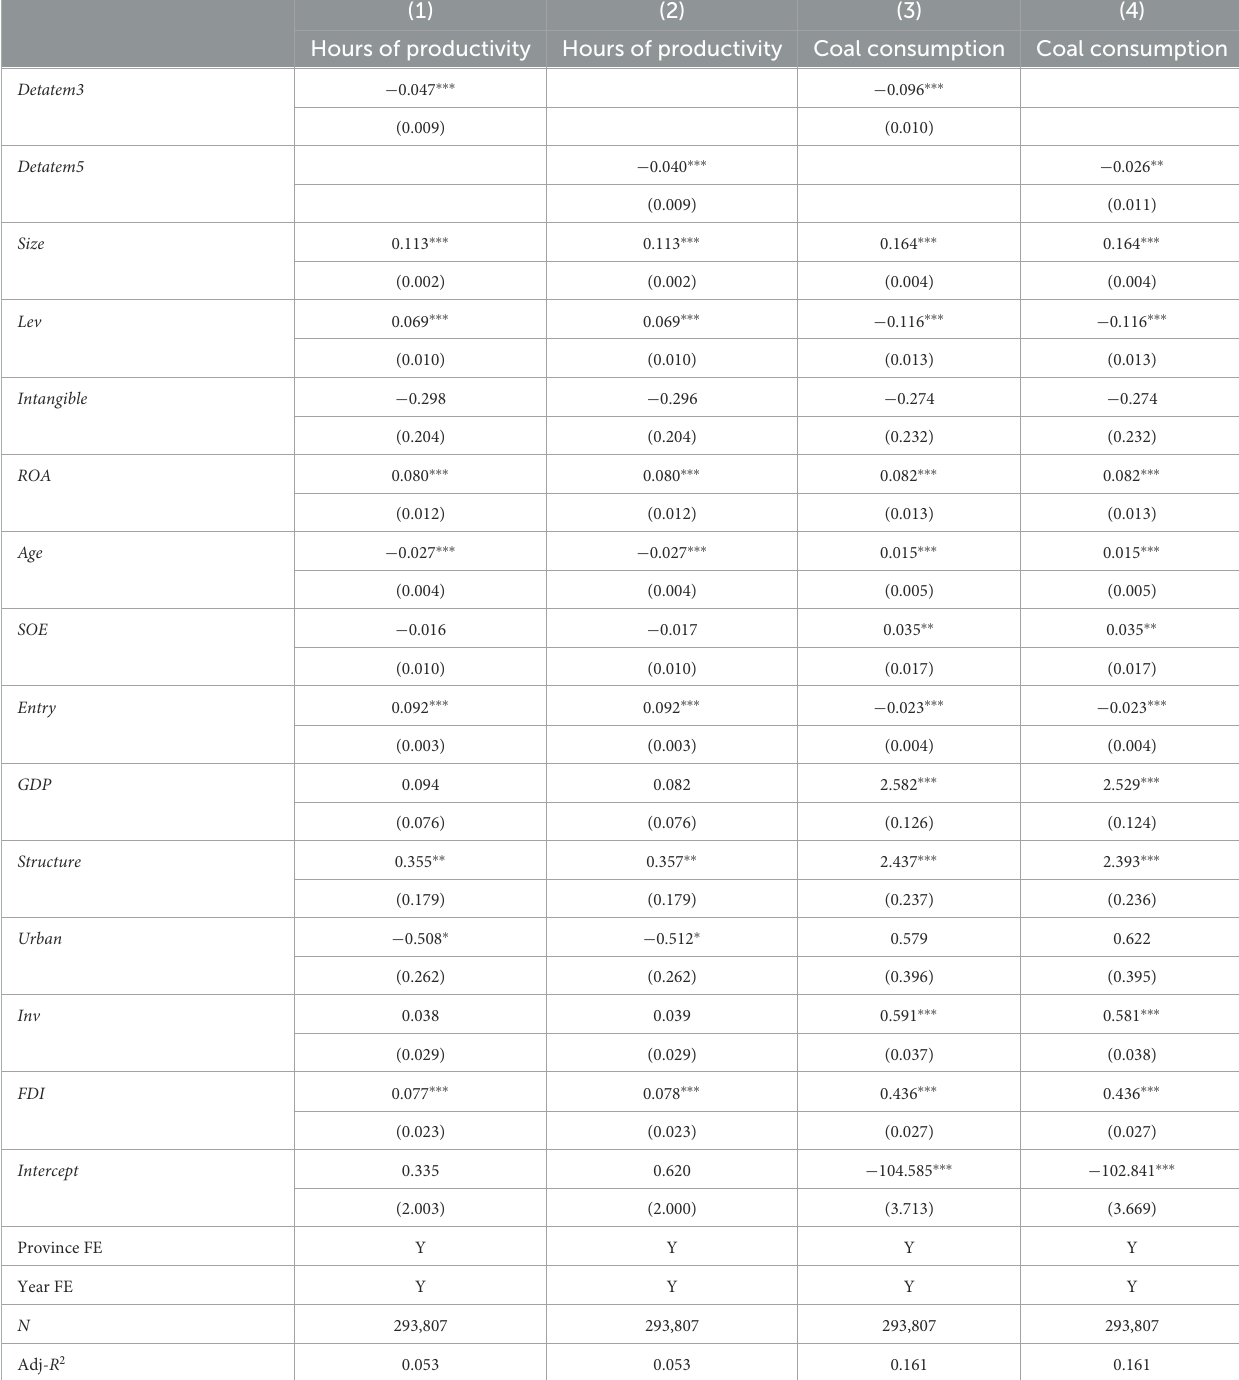
TABLE 12 Climate change and firms’ productivity